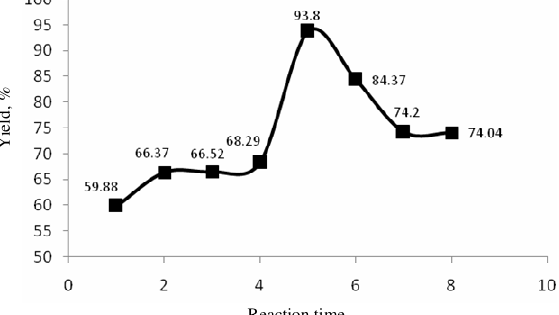
Figure 4 . Effect of reaction time on on the esterification reaction of oleic acid and oleyl alcohol